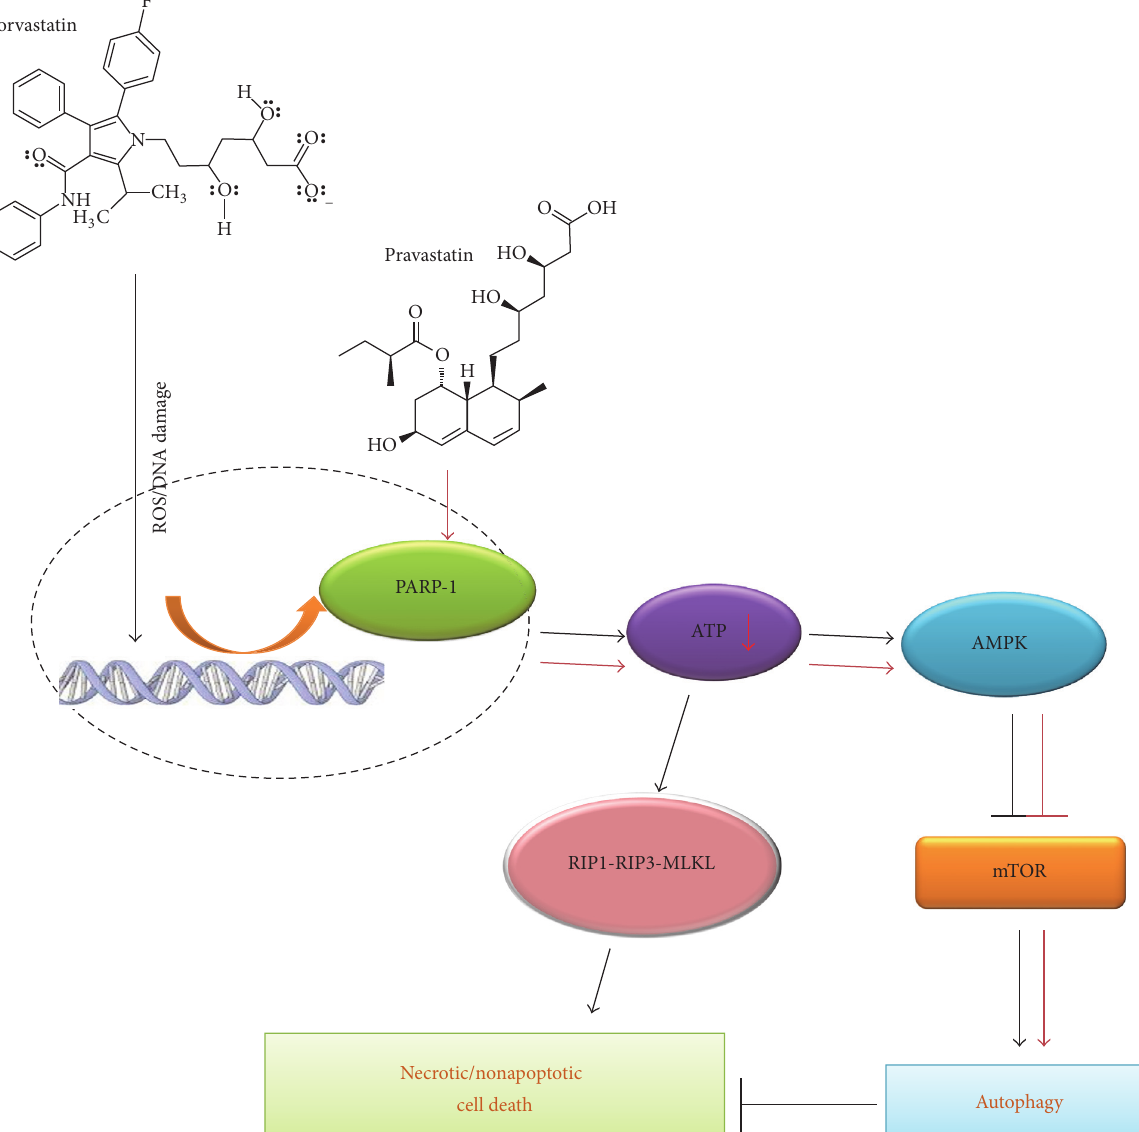
Figure 8: Illustration of the mechanisms of AS- and PS-induced autophagy and cell death. AS- and PS-induced autophagy and cell death are mediated by PARP1 activation, ATP depletion, AMPK activation, and mTOR and RIP1-RIP3-MLKL